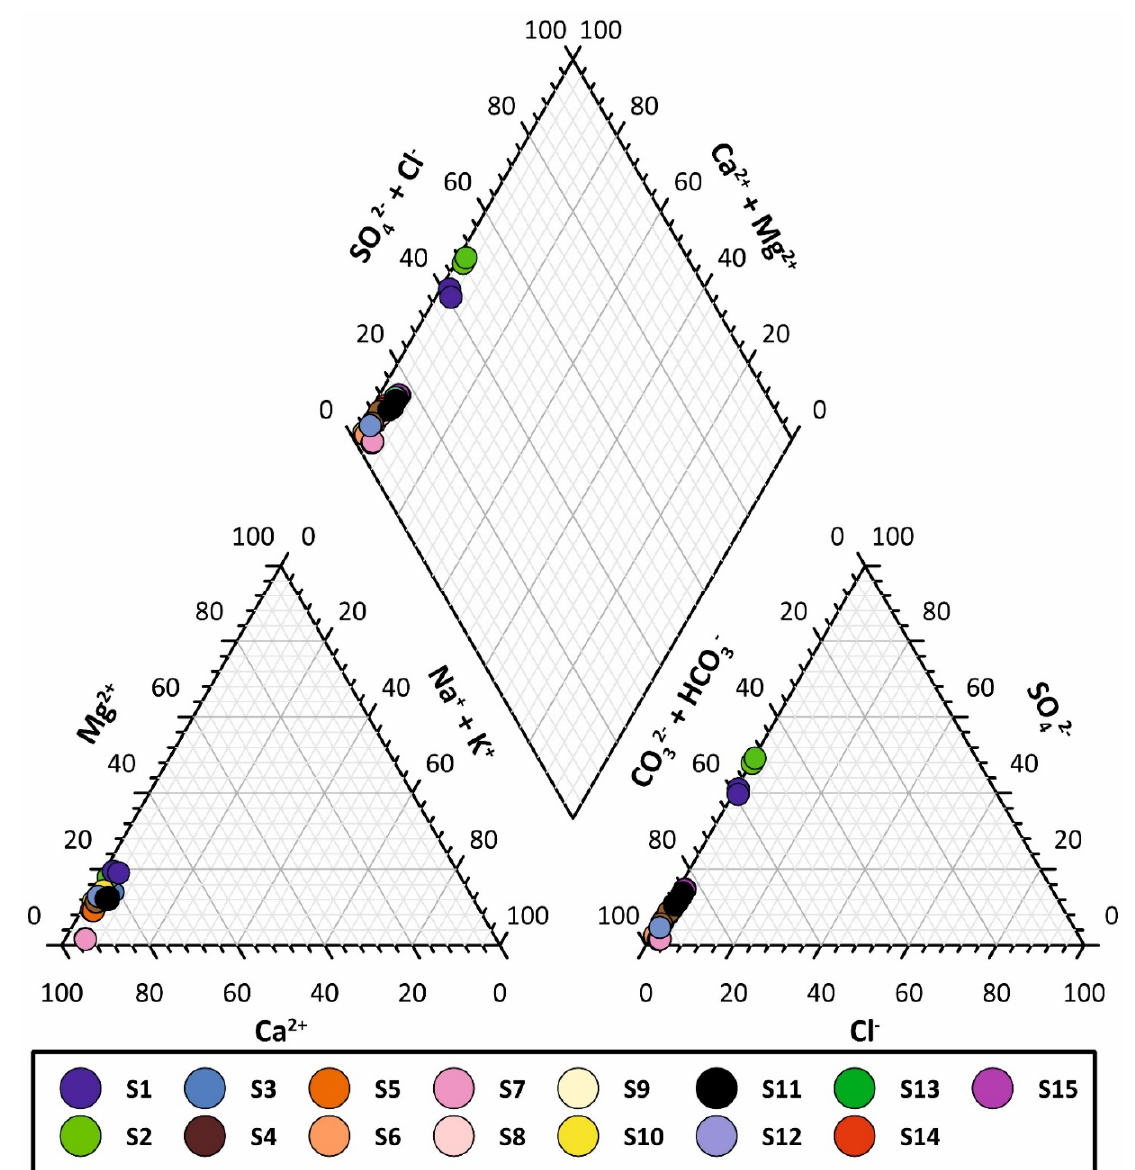
Figure 2 . Piper diagram of groundwater samples from the San Vittorino Plain. All samples are predominantly enriched in bicarbonate and calcium ions (fresh waters and mixing waters; Ca-HCO 3 facies). Only springs of the Antrodoco area (i.e., S1 and S2) are included in the calcium-sulphate waters domain (mineralized waters; Ca-SO 4 facies). For spring location see Figure 1.